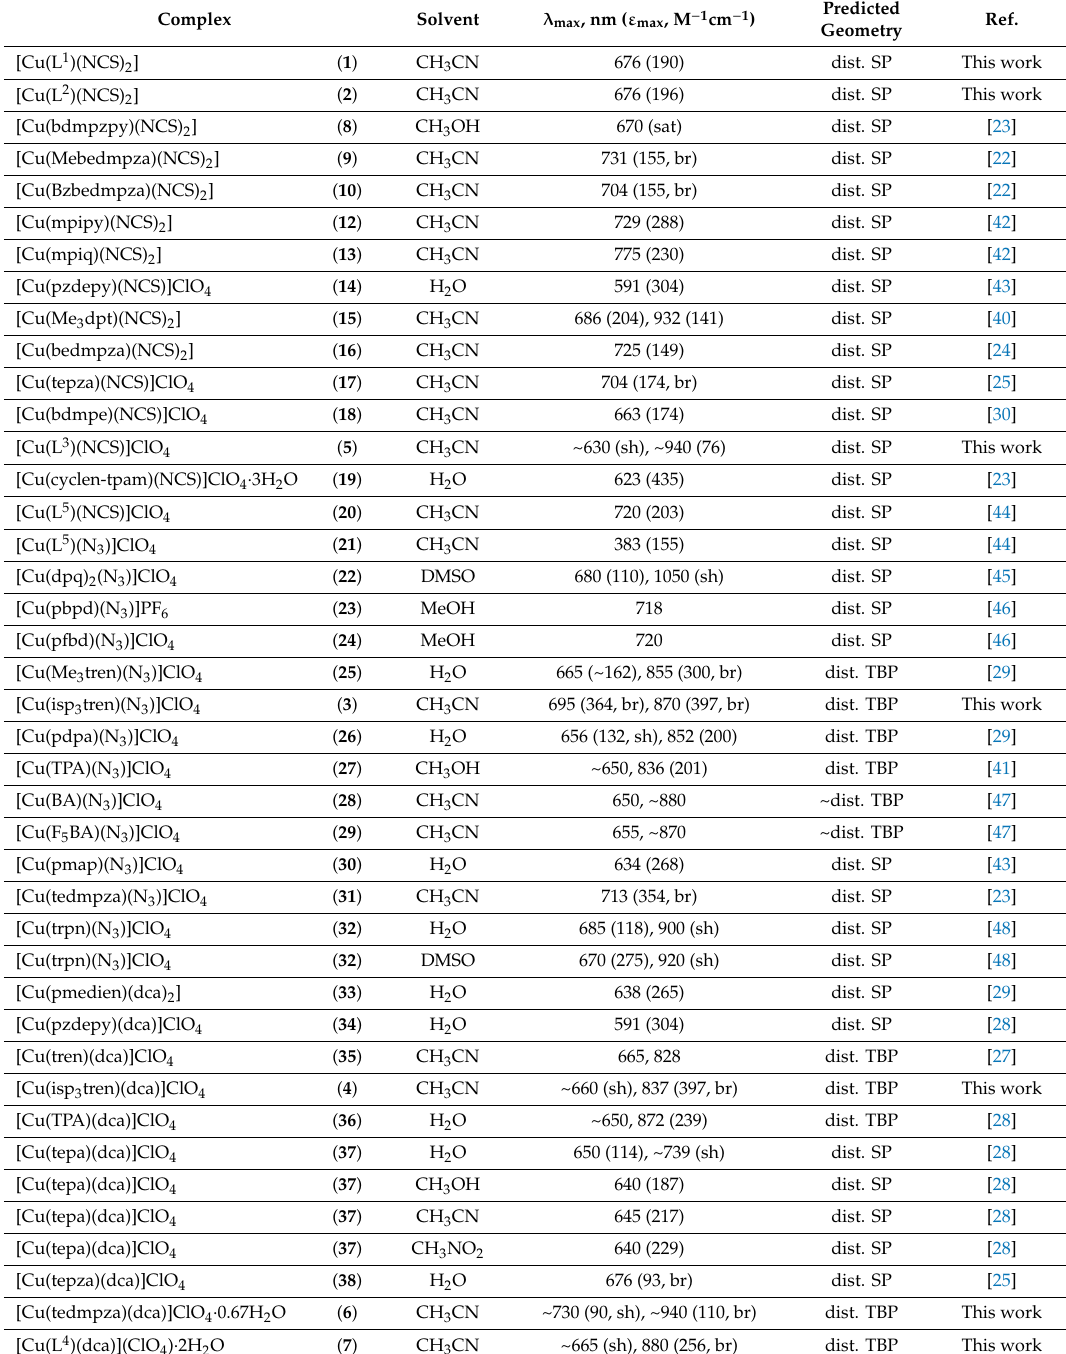
Table 2. The Visible spectral data in mononuclear five-coordinated pseudohalido-copper(II) complexes in solutions and the assigned predominant stereochemical